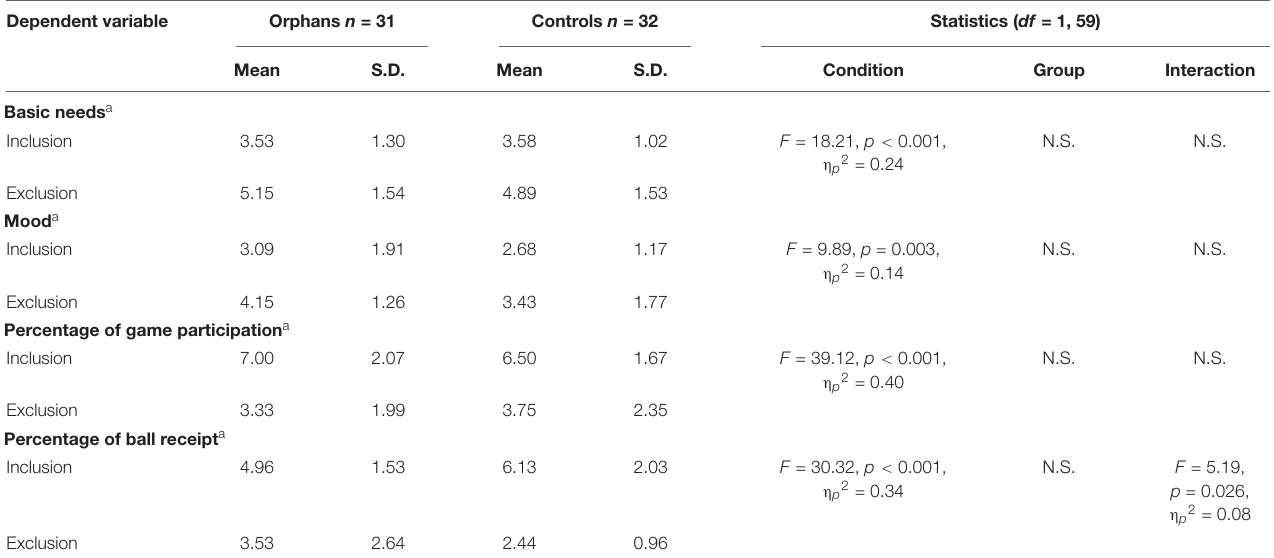
FIGURE 1 | Procedures for the Trust Game. TABLE 2 | Manipulation check of social